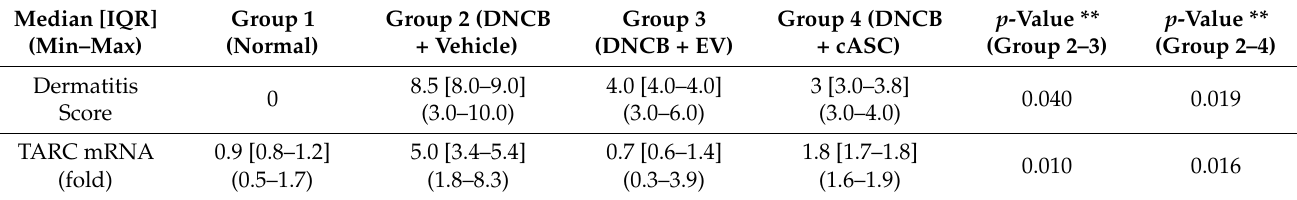
Table 2. Statistical analysis II (nonparametric distribution).